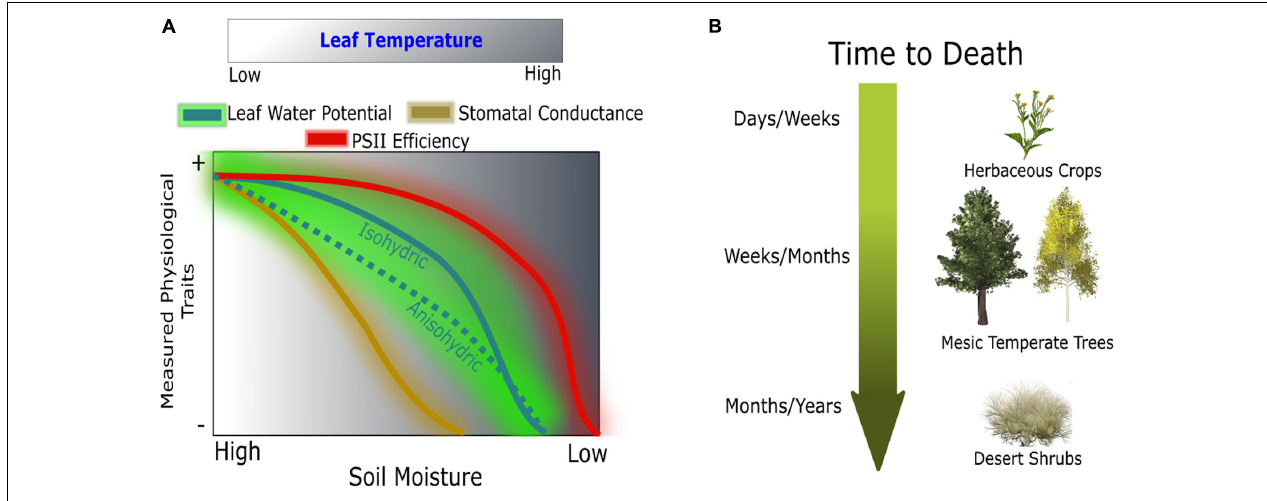
FIGURE 1 | Conceptual hypothesis of physiological responses during drought (A) and susceptibility across a spectrum of drought tolerance species (B) . Comparison between linear responses of gas exchange and threshold responses of leaf water potential and PSII efficiency across a normalized gradient of leaf temperature.